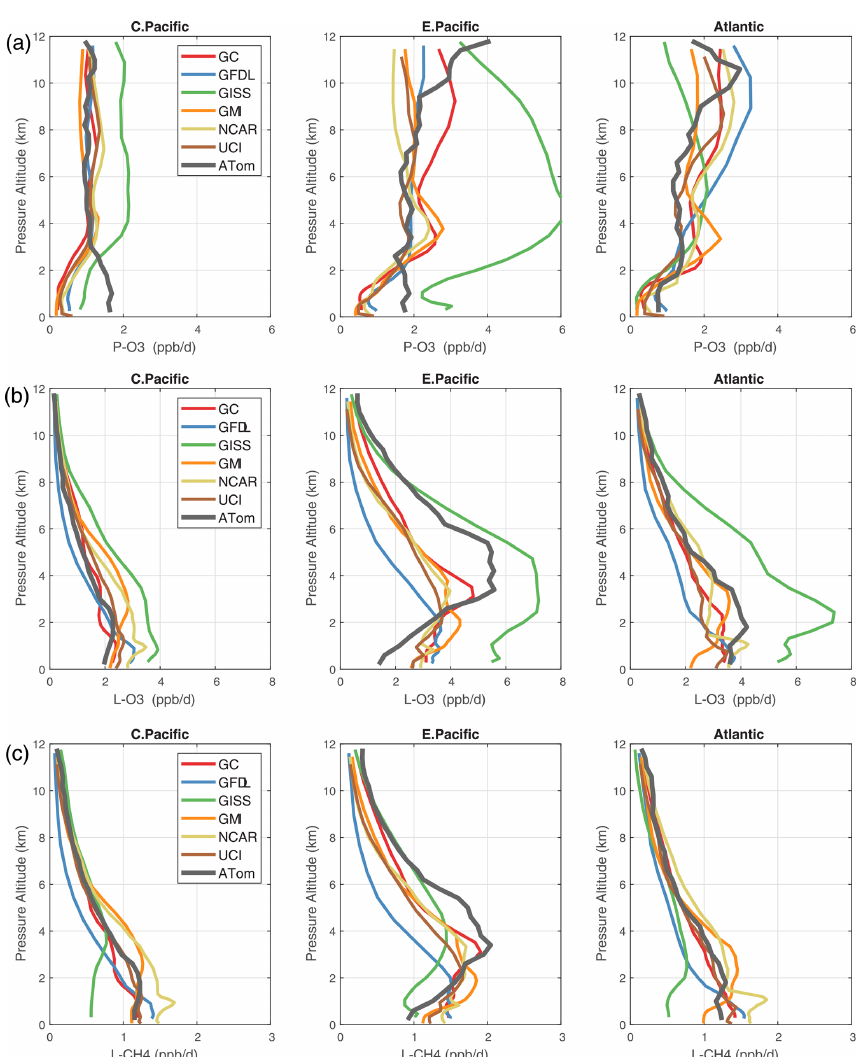
Figure 3. Mean altitude profiles of reactivity (rows: P-O3, L-O3, L-CH4 in ppbd − 1 ) in three domains (columns: C. Pacific, 30 ◦ S–30 ◦ N by 180–210 ◦ E; E. Pacific, 0–30 ◦ N by 230–250 ◦ E; Atlantic, 30 ◦ S–30 ◦ N by 326–343 ◦ E; ranges are the model blocks). Air parcels are cosine (latitude)-weighted. ATom-1 (gray) results are from Fig. 2, while model results are taken from the August climatologies in Prather et al.